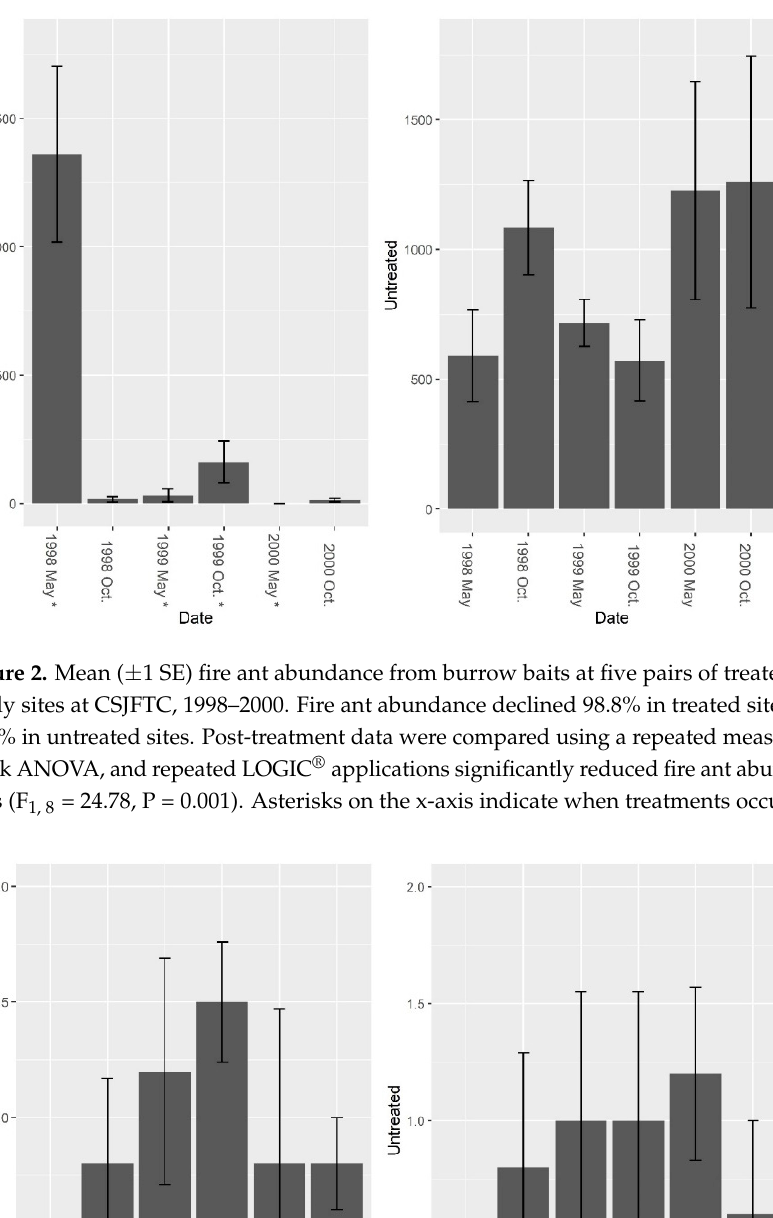
Figure 4. Mean (±1 SE) ant (excluding fire ant) species Shannon diversity indices collected from burrow bait at five pairs of treated and untreated study sites at CSJFTC, 1998–2000. There were no significant differences between study sites from a randomized block design ANOVA (F 1, 8 = 0.14, P = 0.722). Asterisks on the x ‐ axis indicate when treatments occurred.